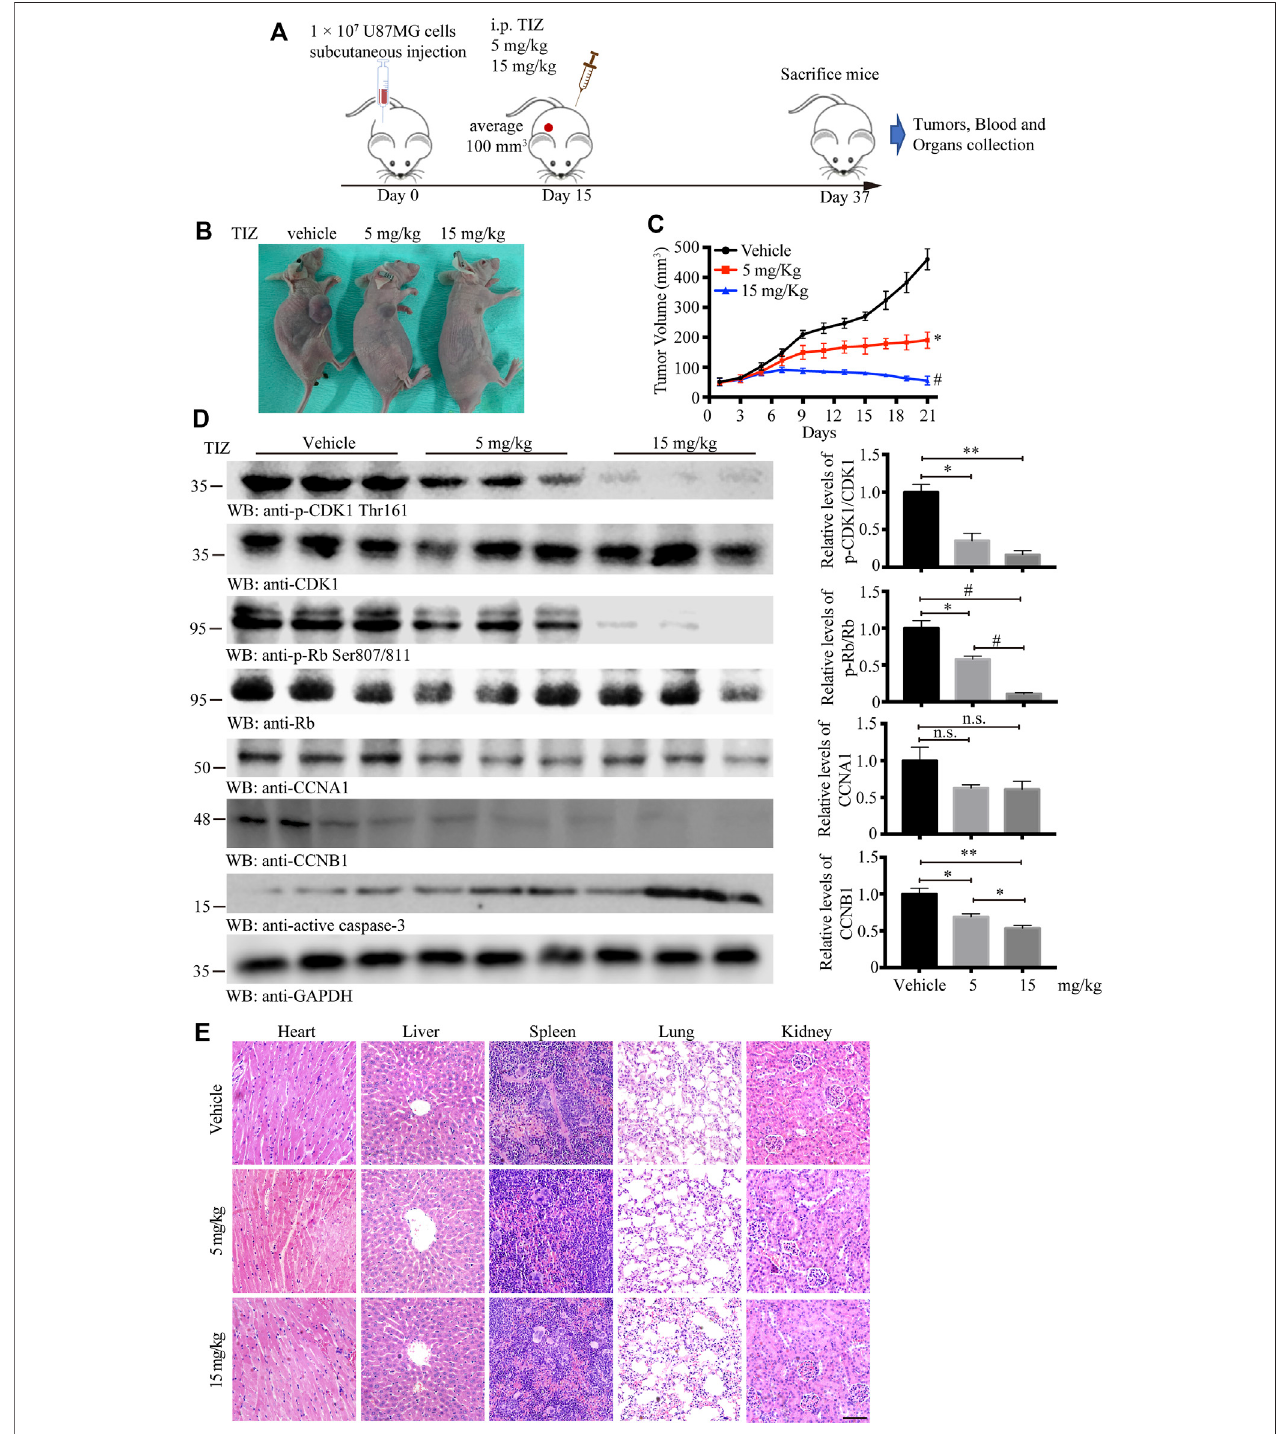
FIGURE 4 | TIZ inhibits GBM growth in a subcutaneous xenograft nude mouse model. (A) Schematic of xenograft mouse model establishment and TIZ administration. (B) RepresentativeimagesofGBMgrowthafterdifferentdosagesofTIZadministration. (C) TIZinhibitedGBMgrowthasmeasuredbytumorvolume( n = 6). (D) Western blot analysis of tumor lysates with various indicated antibodies. Quanti fi cations of relative protein levels are shown in the right panel ( n = 3). Blot data are representative of three independent experiments. (E) TIZ administration displayed no detectable toxicity. Histological analysis of H&E-stained tissue sections of representative mice in theTIZ or vehicle-treated group. Scale bar,100 µm. Dataare presented asthemean ±SD (n.s. means nosigni fi cance,* p < 0.05, ** p < 0.01, # p < 0.001).